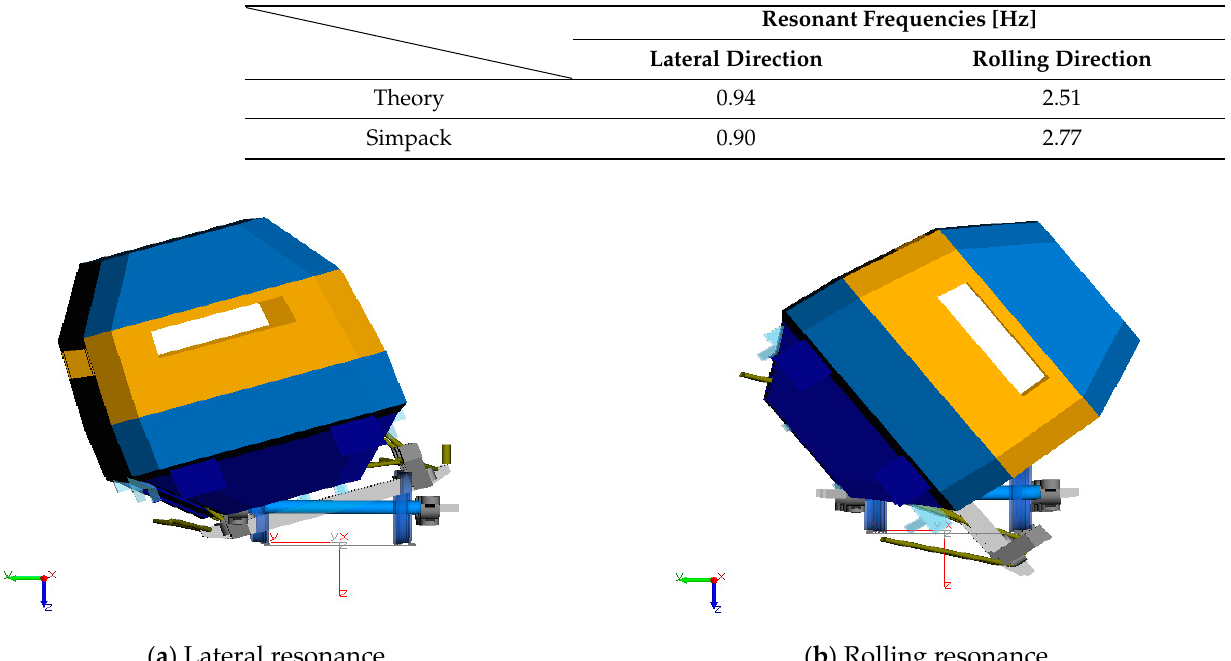
Figure 9. The vehicle behavior under the resonant frequencies. Table 6. The comparison of the resonant frequencies between the theoretical formula and Simpack.